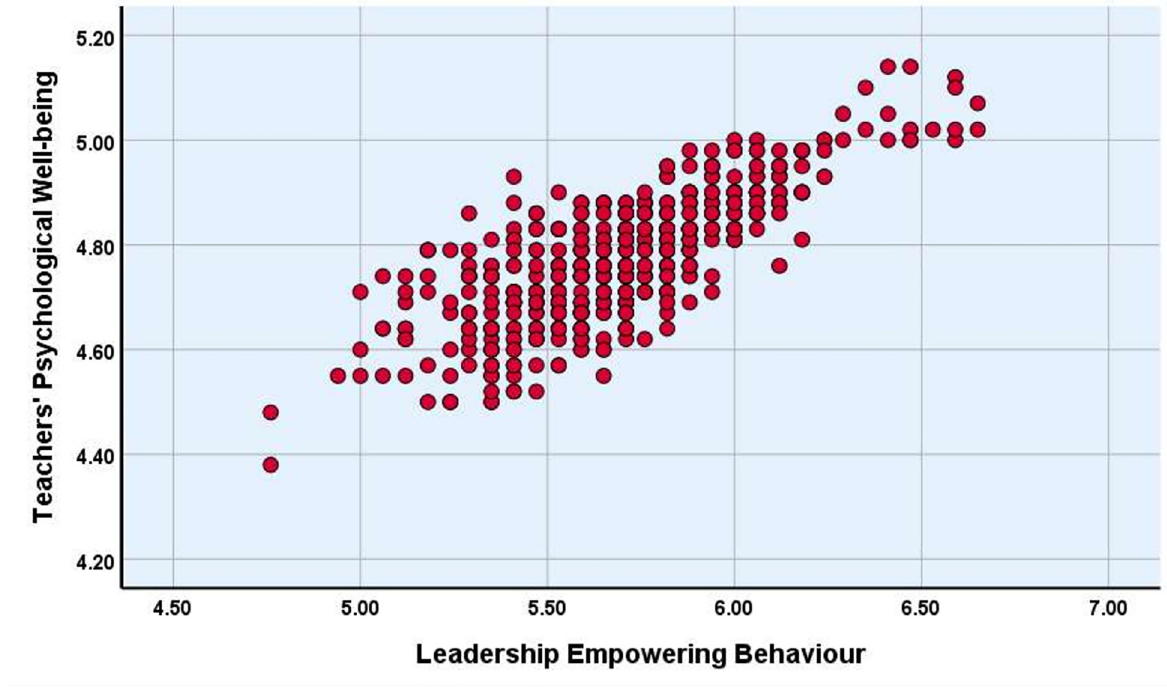
Fig 2. Pearson’s product-moment correlation between leadership empowering behaviour and teachers’ psychological well-being. The scatterplot undoubtedly demonstrates a significant positive relationship between overall leadership empowering behaviour and teachers’ psychological well-being at secondary